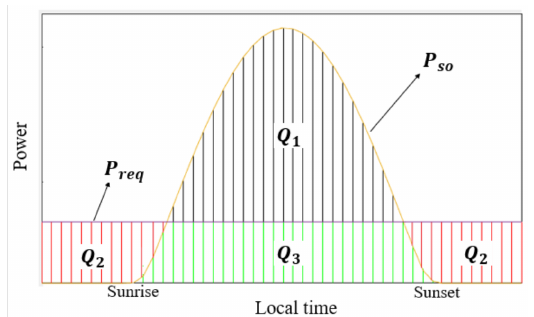
Figure 5. Sketch of energy